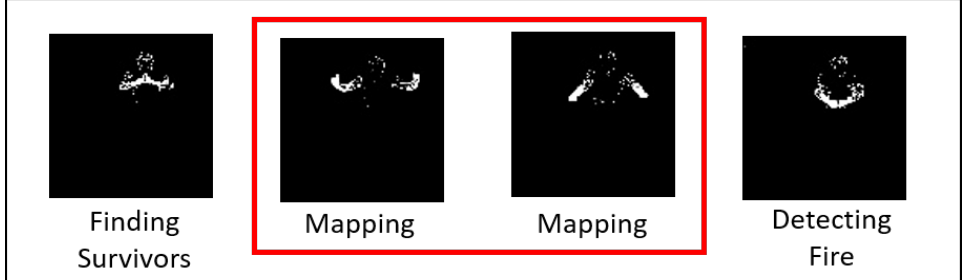
Figure 3. Description of the bespoke “Frame Vote” algorithm. Each frame is classified as one of the possible gestures. The final classification is made by comparing which gesture was most often classified within 20 frames. In this example, two out of four frames have been classified as “Mapping”, so the algorithm chooses that gesture over the other